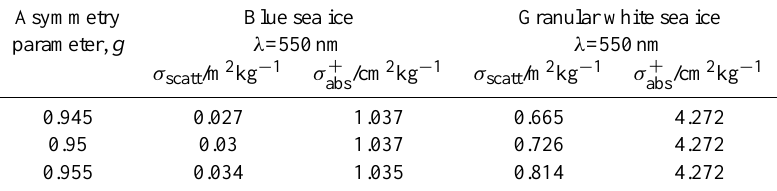
Table 2. Variation in derived σ scatt and σ + of the blue sea ice and granular white sea ice from variation of the asymmetry parameter, g abs